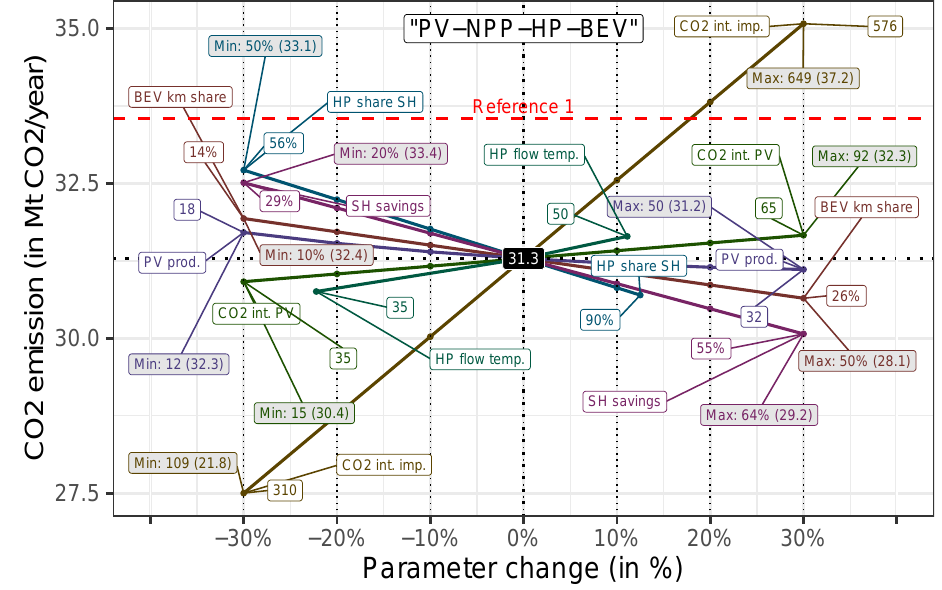
Figure 28. Sensitivity plot of the total CO 2 emissions for scenario “PV-NPP-HP-BEV” with respect to plausible percentage changes of the key parameters in Table 3. “Reference 1” is the reference scenario “SQ + Retrofit” from Figure